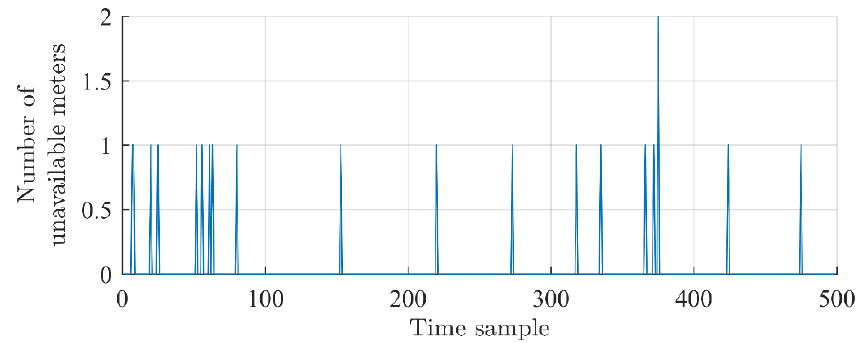
Figure 2. Network meter unavailability vs. time.